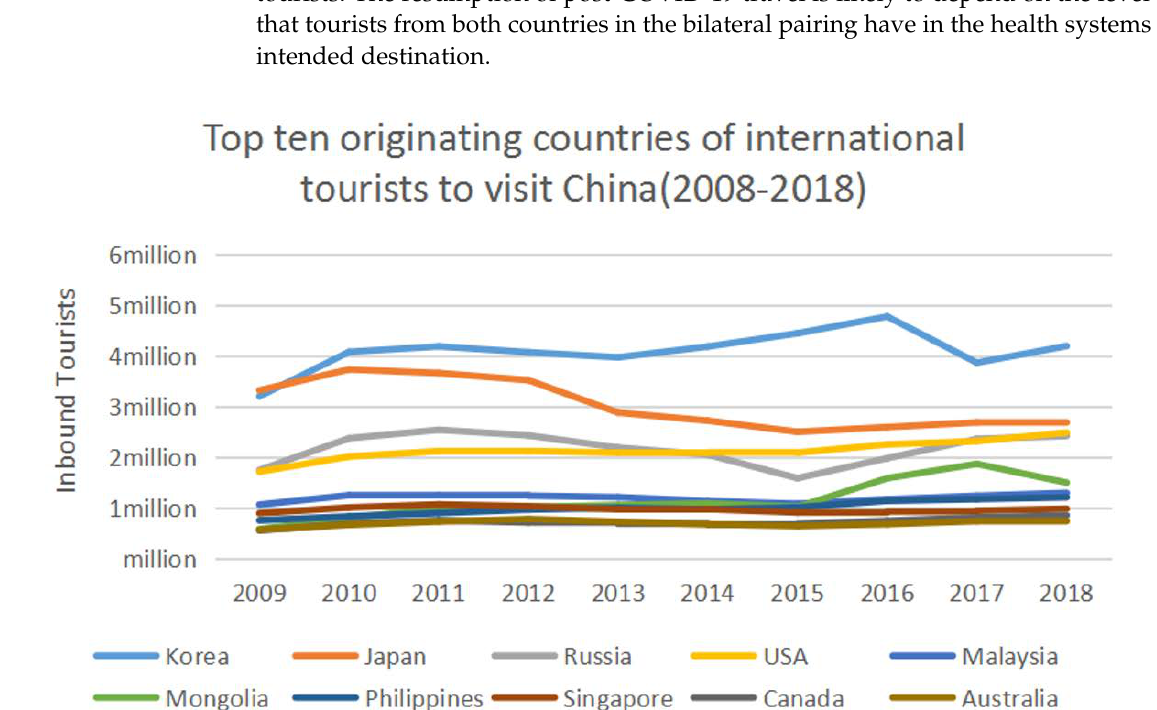
Figure 2. Top 10 originating countries of international tourists visiting China (2008-2018; Source: National Bureau of Statistics (2020) https://data.stats.gov.cn/ (accessed on 20 November